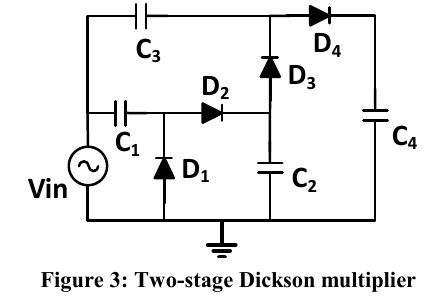
Figure 3: Two-stage Dickson multiplier